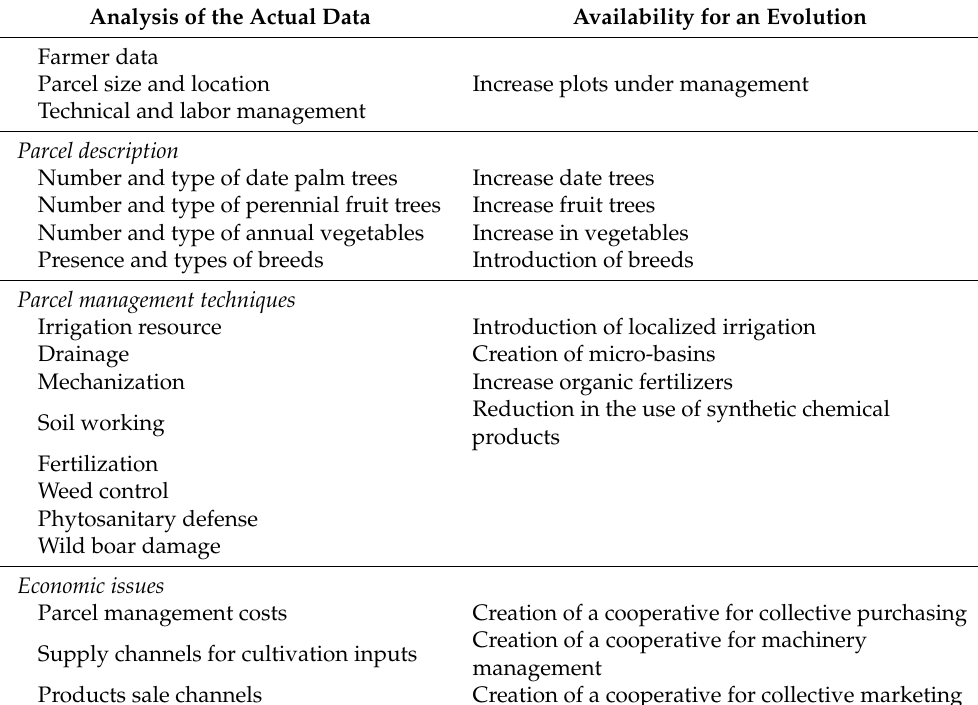
Table 1. Main topics included in the semi-structured interviews submitted to growers from the